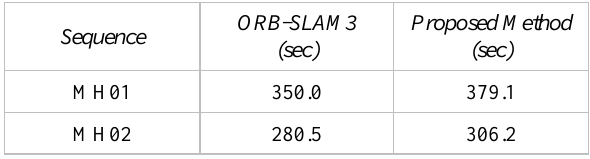
Table 2. Processing time of each algorithm for both